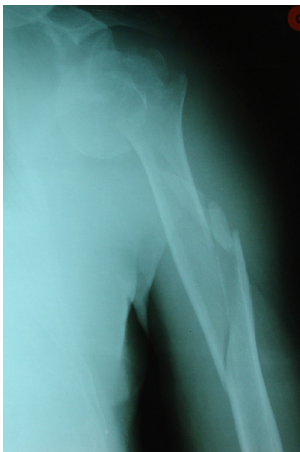
Figure 1. Initial X-ray of our patient.